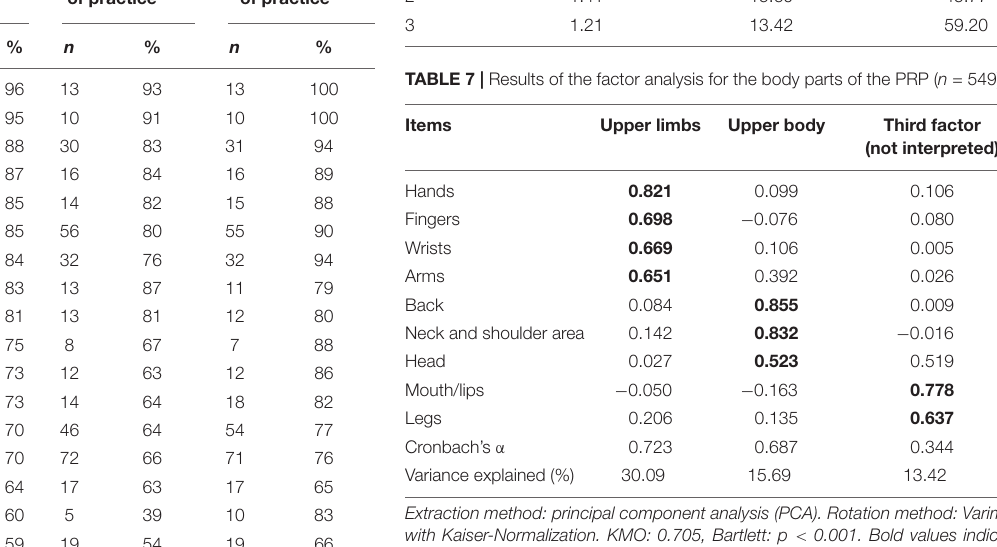
TABLE 6 | Results of the factor analysis: eigenvalues and explained variance. Factor Eigenvalue % of variance Cumulative%